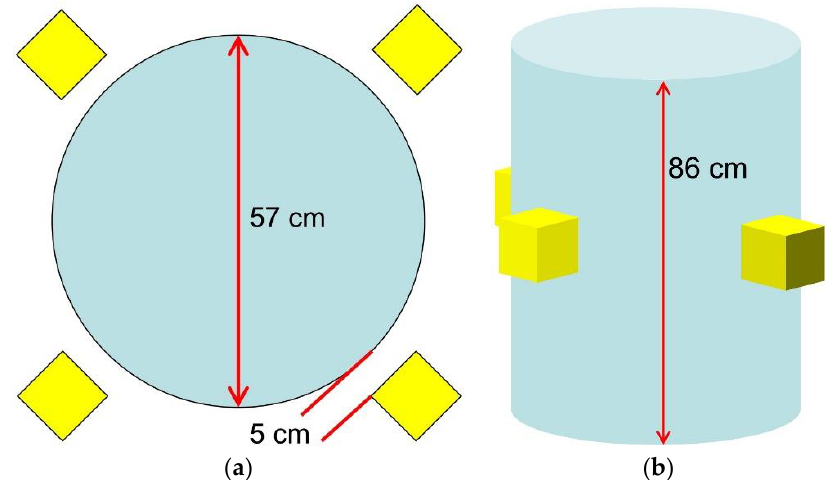
Figure 24. Sketch of the simulated radwaste package along with four SiLiF detectors around it. ( a ) Top view; ( b ) perspective view.